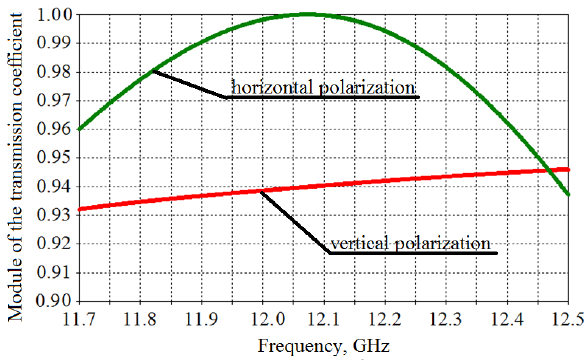
FIGURE 5. Simulated conductivity of the pin for different heights.